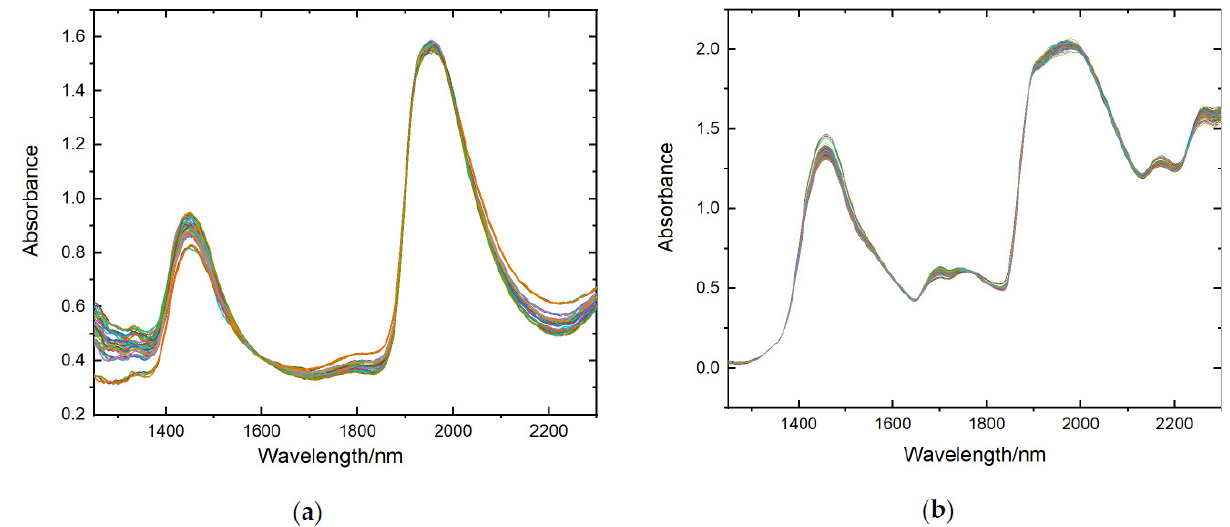
Figure 4. Absorbance spectra of different samples. ( a ) milk samples; ( b ) alcohol samples.